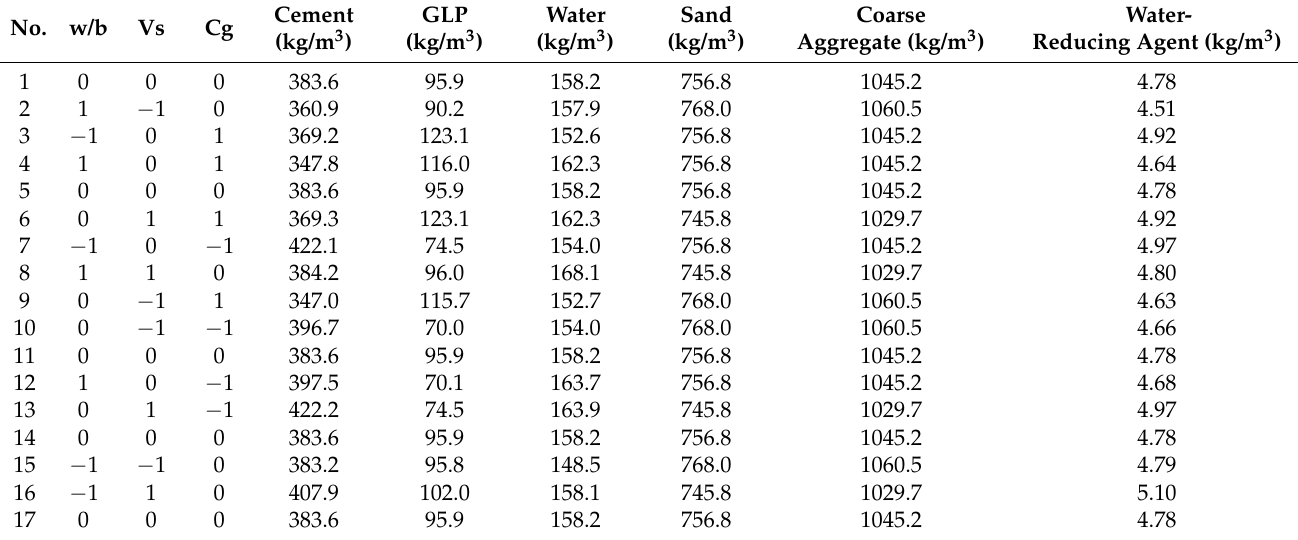
Table 4. Mix proportions of concrete.